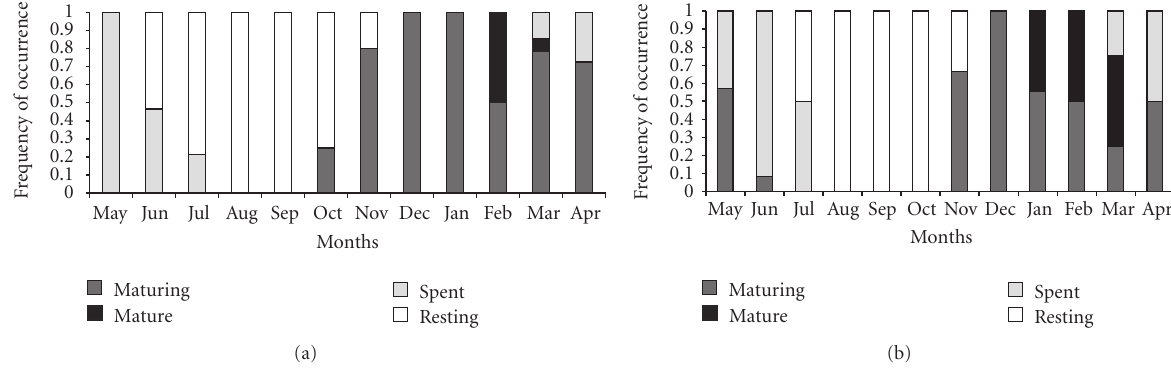
Figure 5: Monthly frequency of occurrence of gonad maturation stages in females (a) and males (b) of Prochilodus brevis .